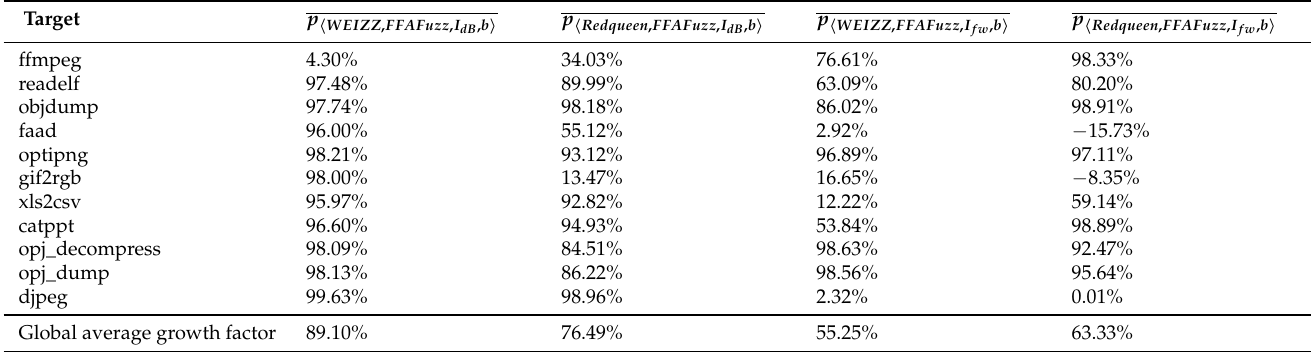
Table A1. The average growth factors in